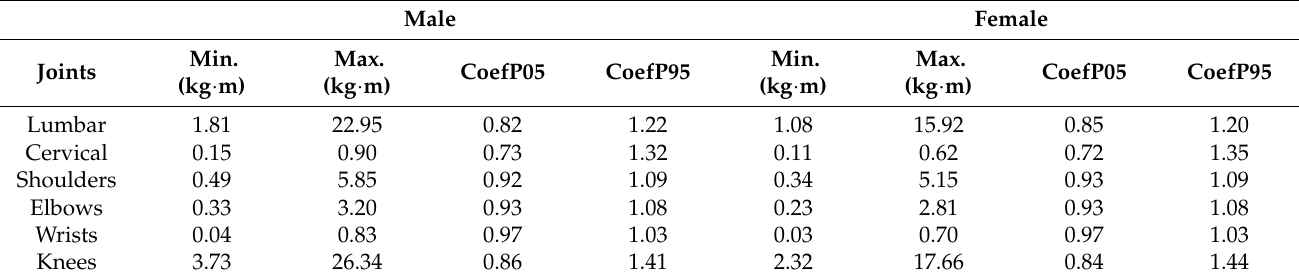
Cervical Shoulders Wrists